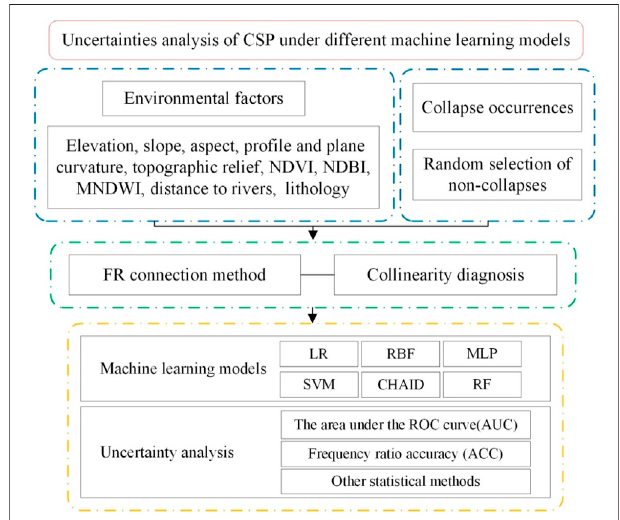
FIGURE 1 | Flow chat of regional collapse susceptibility prediction